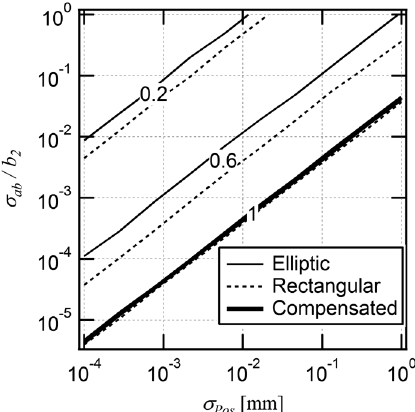
FIG. 9. Estimated sensitivity to position errors. The numbers on the curves are for the aspect ratio. For each point, the standard deviation was obtained from 100 samples.